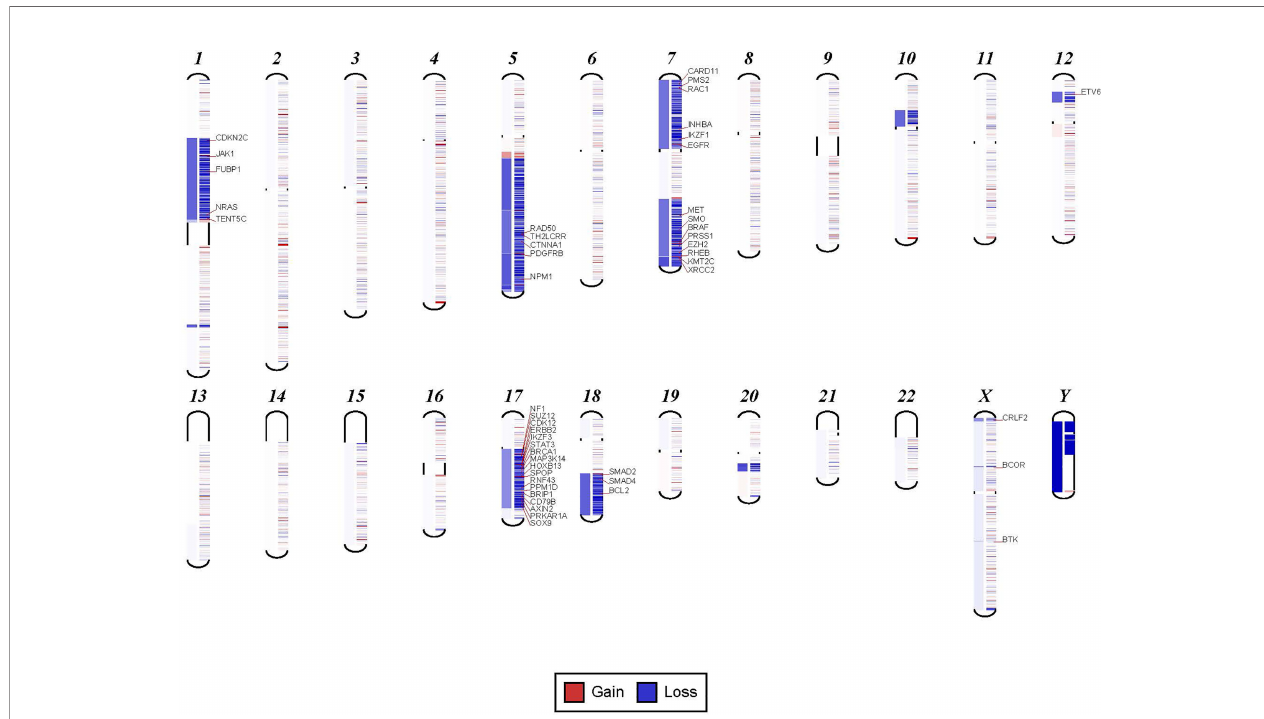
FIGURE 3 | Examples in which cytogenetic complex fi ndings can be signi fi cantly simpli fi ed by NGS analysis. Cytogenetic description for this sample states 43 to 45 chromosomes with the following abnormalities: “ der(1)del(1)(p12p31)add(1)(q12),+3,add(3)(p11.2),add(3)(q11.2), del(5)(q13q34),add(6)(q21),-7,-10,del(10)(p13p15), der(11)t(11;17)(q23;q11.2),-12,-16,-17,add(17)(q11.2),add(18)(q21.1),add(18)(q21.3),-20,del(21)(q21q22),+3 4mar[cp13]/89 90,slx2[2]/46,XX[5]. NGS shows major abnormalities in 1p-, 5q-, -7, 10p-, 12p-, 17q-, 18q- and 20q-. However, in addition deletions of speci fi c genes on chromosome X are also